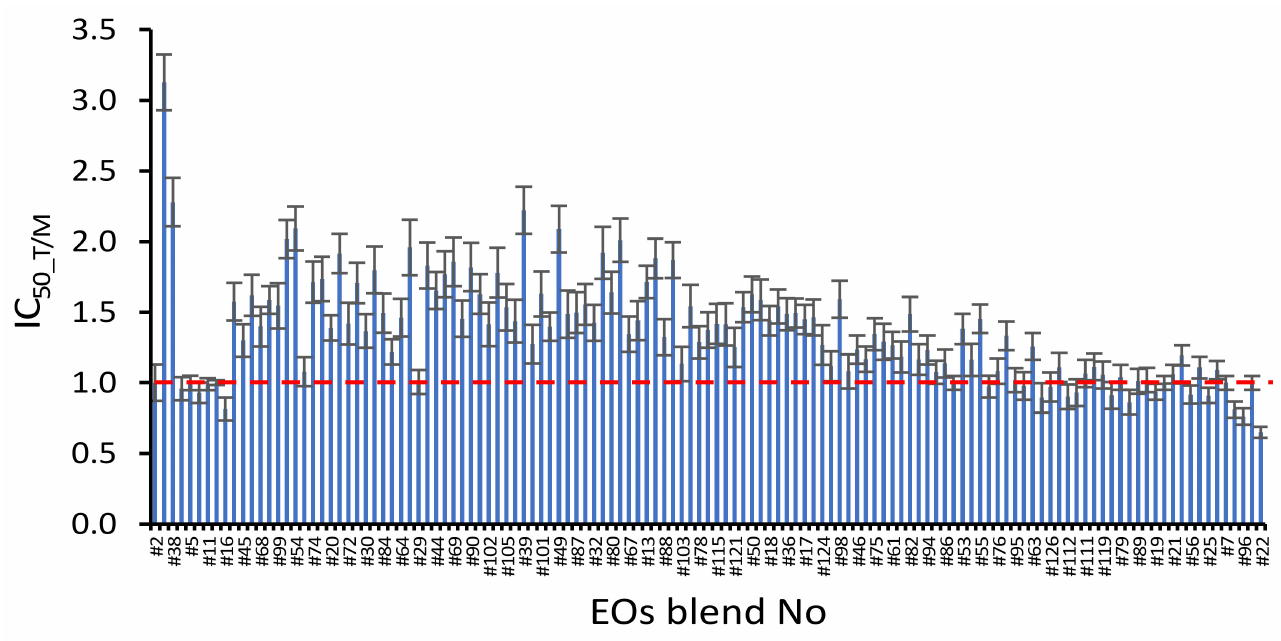
Figure 4. Ratios between theoretical and measured 50% inhibitory concentration (IC 50_T/M ) of the investigated 127 essential oils (EOs) blends. The datapoints lying on the dashed line (IC 50_T/M = 1) reflect an additive antibacterial activity of EOs against Aeromonas veronii bv. sobria , while the datapoints above and below the dashed line represent synergistic and antagonistic interactions of EOs,